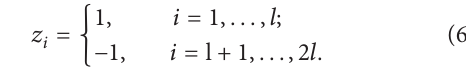
Table 2: Experimental treatments of Ca 2+ penetration. Experimental treatments 𝑇1 𝑇2 𝑇3 𝑇4 Concentration of CaSO /g ⋅ L − 1 4